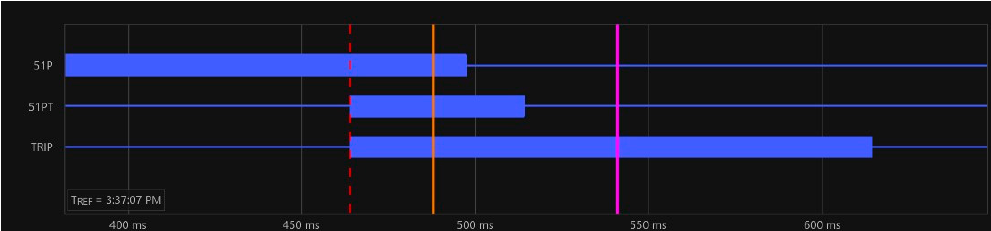
Figure 39. Trip signal generated by R1 under IDMT scheme.